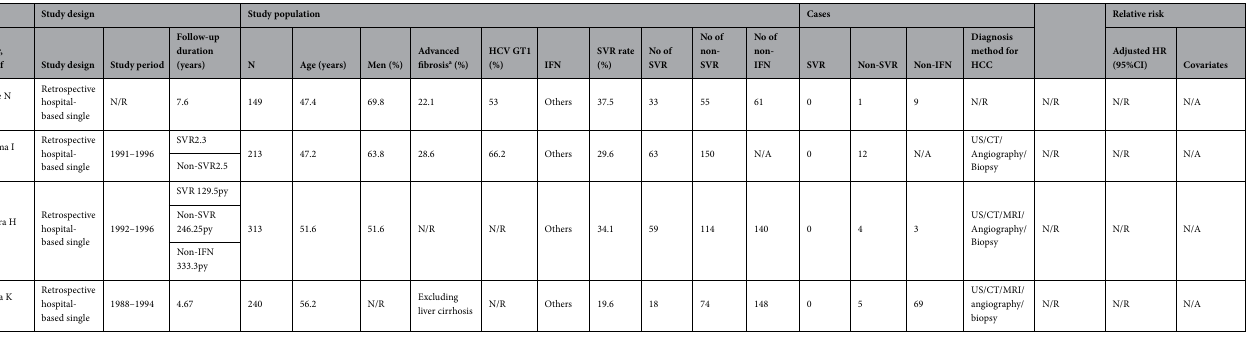
Table 1. Characteristics of studies included in the present systematic review on response to antiviral therapy for chronic hepatitis C and hepatocellular carcinoma occurrence. AFP alpha fetoprotein, Alb albumin, ALT alanine aminotransferase, AST aspartate aminotransferase, CI confidence interval, CT computed tomography, DM diabetes mellitus, FBS fasting blood sugar, GT genotype, HCV hepatitis C virus, HR hazard ratio, IFN interferon, MRI magnetic resonance imaging, N or No number, N/R not recorded, N/A not appreciable, NVR non-viral response, OGTT oral glucose tolerance test, Peg pegylated, Plt platelet, PR partial response, PT prothrombin time, py person-years, Ref reference, RNA ribonucleic acid, SVR sustained virologic response, T-bil total bilirubin, TCho total cholesterol, US ultrasound. a Stage 3 or 4 liver fibrosis was determined by liver